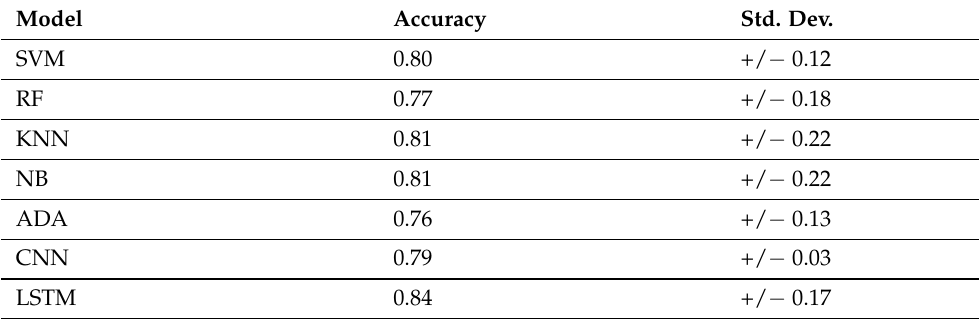
Table 6. Results of K-fold